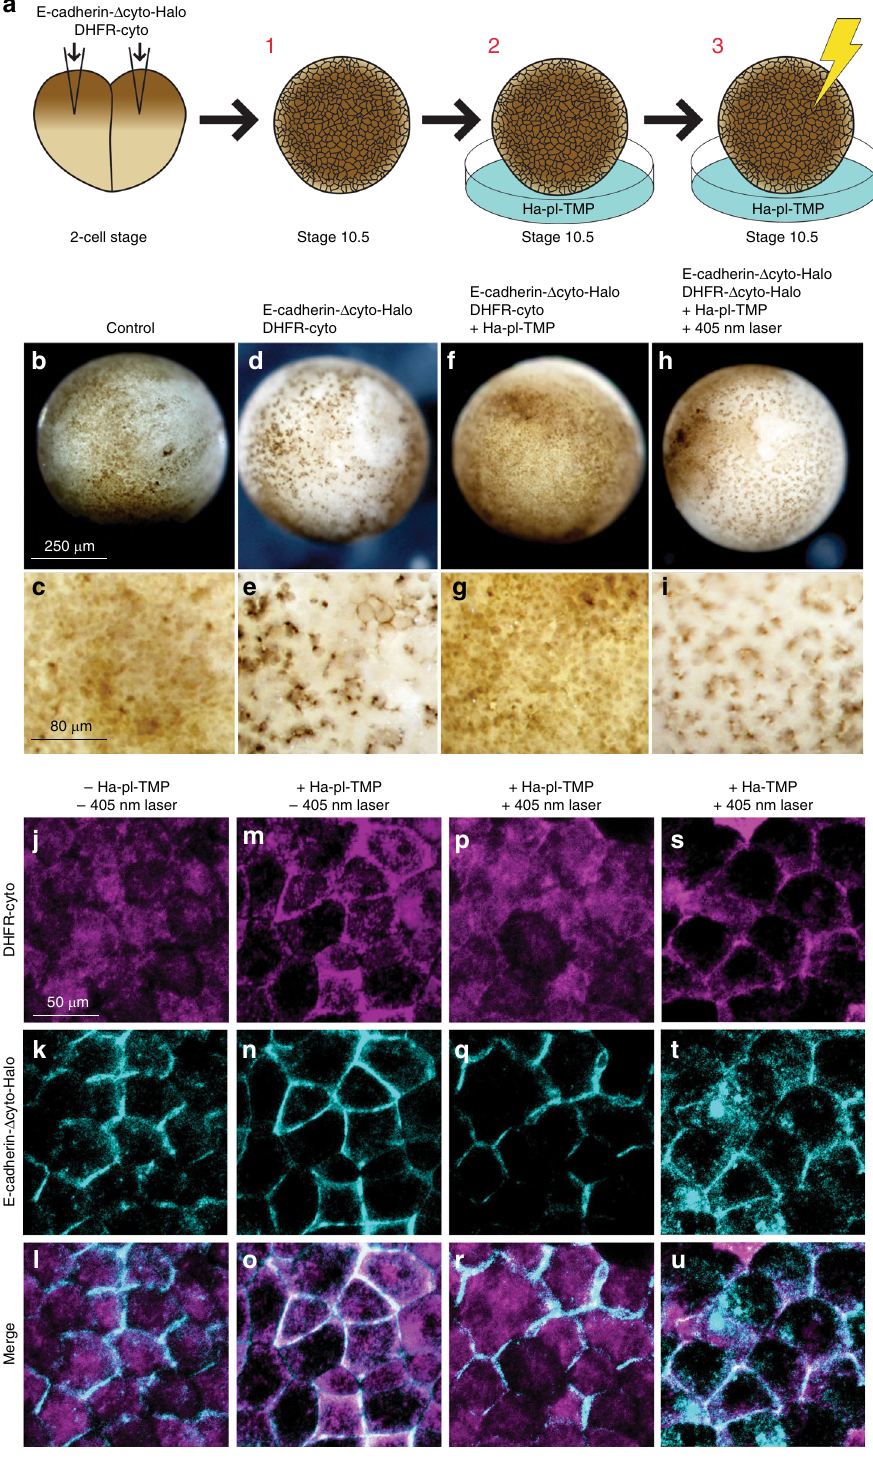
Fig. 7 LInDA tools affect epithelial integrity in vivo. a Diagram of the experimental setup. Xenopus embryos were injected with DHFR-cyto and E-cadherin- Δ cyto-Halo at the two-cell stage and imaged at stage 10.5, with or without the dimerizer and with or without exposure to a 405 nm laser. b – i Epidermal dissociation was observed by co-injection of DHFR-cyto and E-cadherin- Δ cyto-Halo ( d , e ) compared to wild type controls ( b , c ), which was rescued by incubation with the dimerizer ( f , g ). Dissociation was induced by photocleavage under a 405 nm laser ( h , i ). j – u , DHFR-cyto is cytosolic and E-cadherin- Δ cyto-Halo is localized to the cell contact ( j – l ). Upon the addition of Ha-pl-TMP dimerizer, DFHR-cyto translocates to the cell contact ( m – o ), which can be disrupted by exposure to blue light ( p – r ). Blue light fails to prevent accumulation of DHFR-cyto at the cell contact when embryos are incubated with the non-photocleavable Ha-TMP dimerizer ( s – u